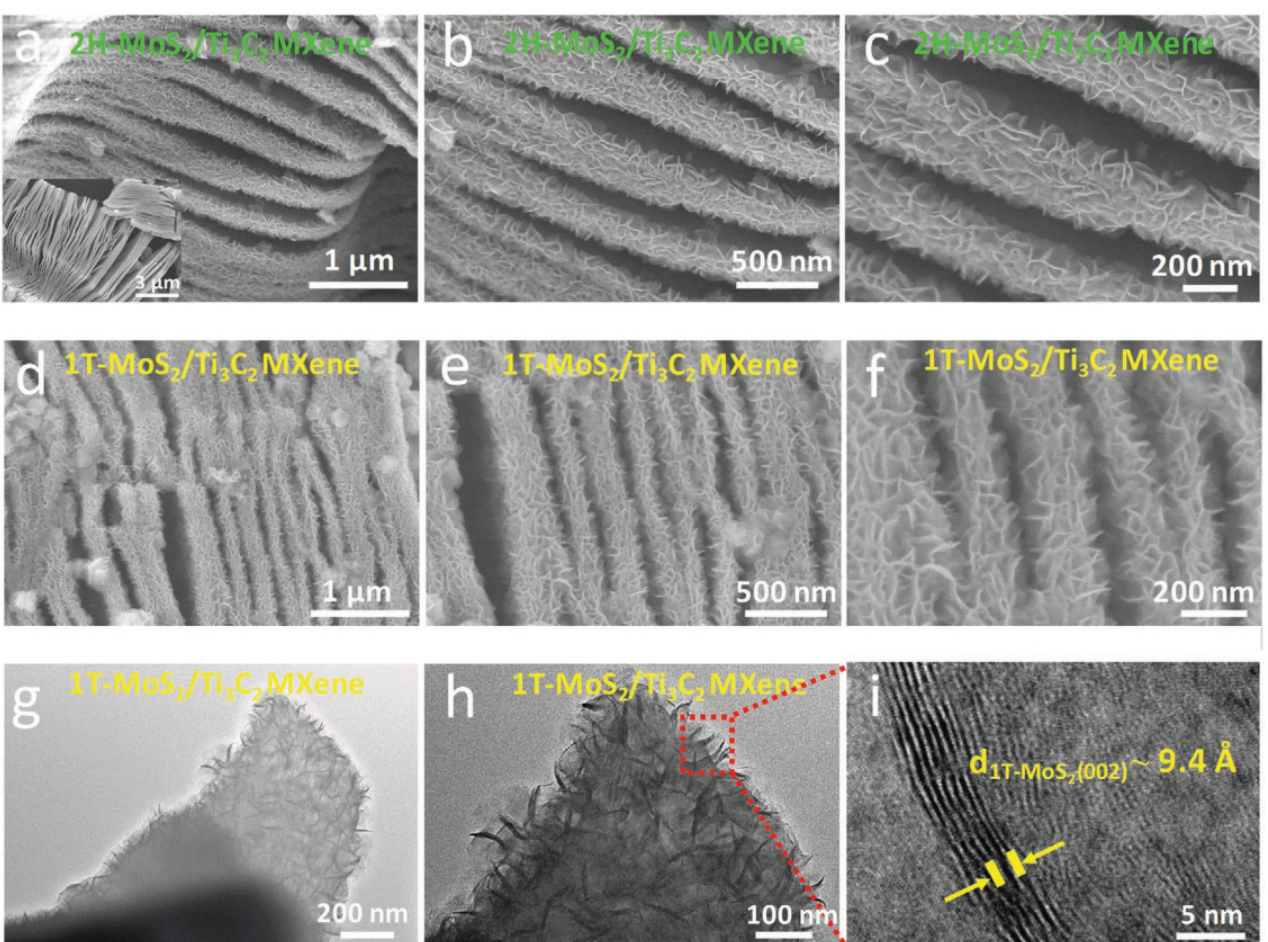
Figure 12. Heterostructures of 2H-MoS 2 /Ti 3 C 2 and 1T-MoS 2 /Ti 3 C 2 with different morphologies by using SEM and TEM image. Reproduced with permission from [87]. Copyright 2019 Wiley.